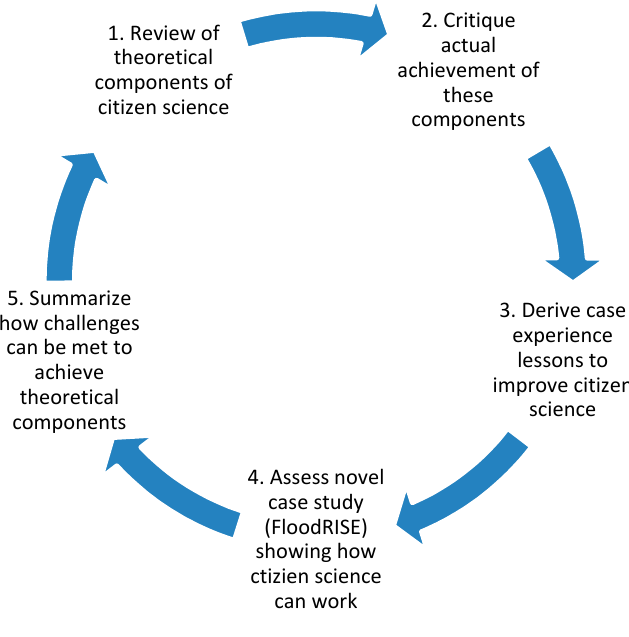
Figure 1. Methodology of study.